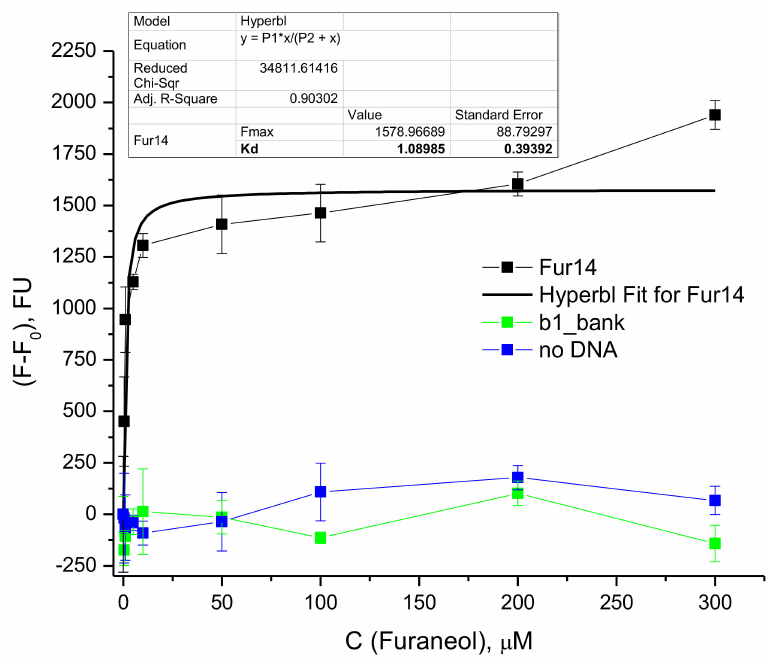
Figure 4. Calculation of the dissociation constant for Fur_14. Measurements were performed in triplicates. Error bars were calculated as standard